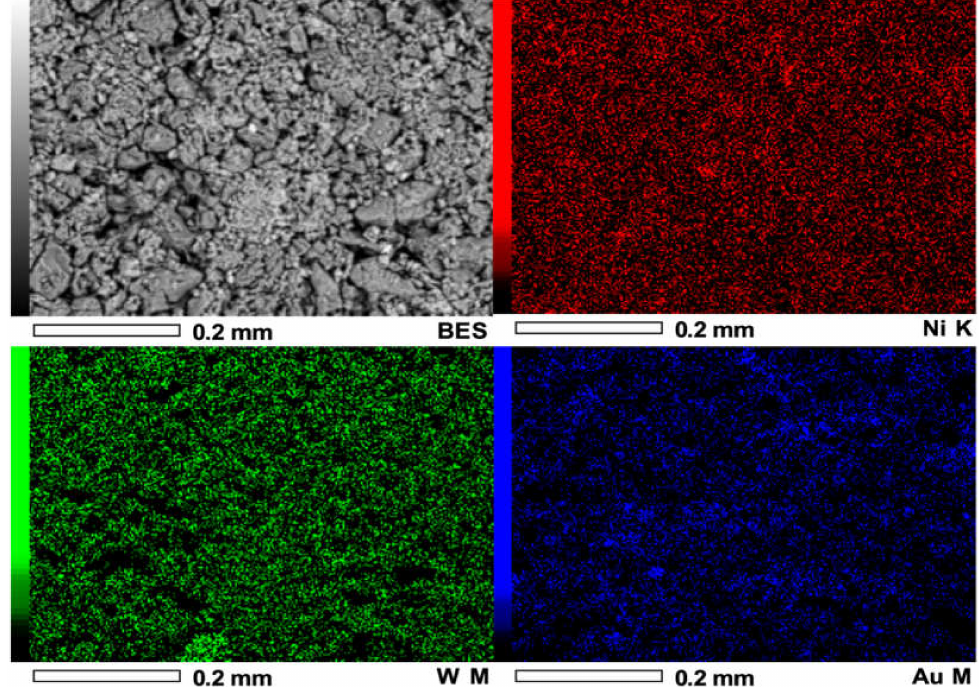
Figure 7. EDX elemental chemical mapping of NiWAu/ACT1